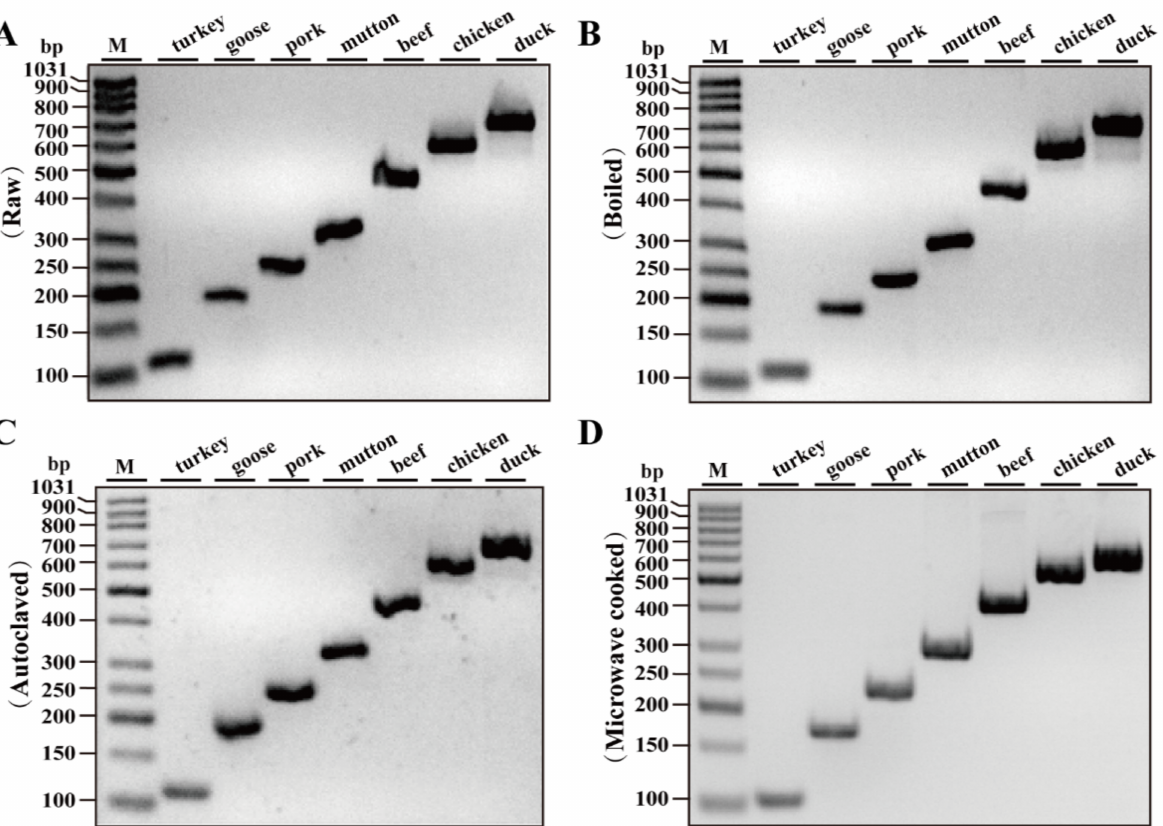
Figure 3. Gel image of the PCR products generated by simplex PCR amplifications with turkey, goose, pig, cattle, sheep, chicken and duck DNA extracted from raw ( A ), boiled ( B ), autoclaved ( C ) and microwave-cooked meat samples ( D ) using each species-specific primer pair. Lane M is ladder